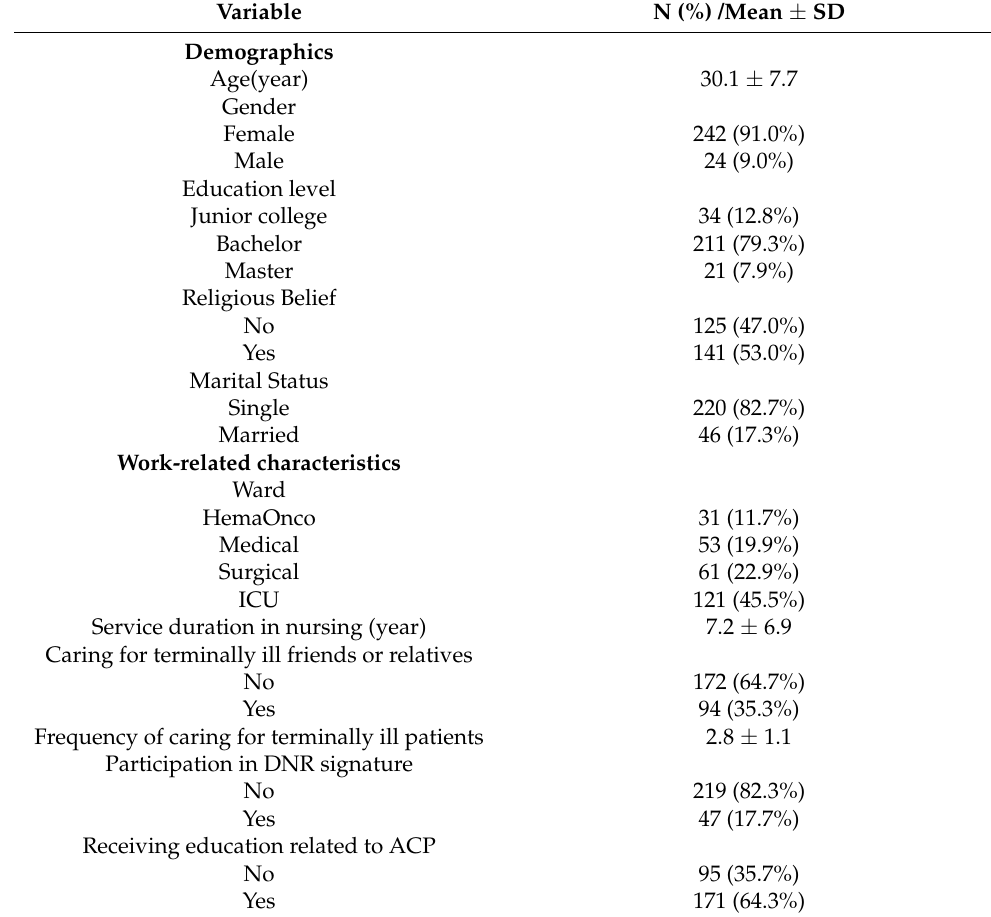
Table 1. Demographics and work-related characteristics (N =